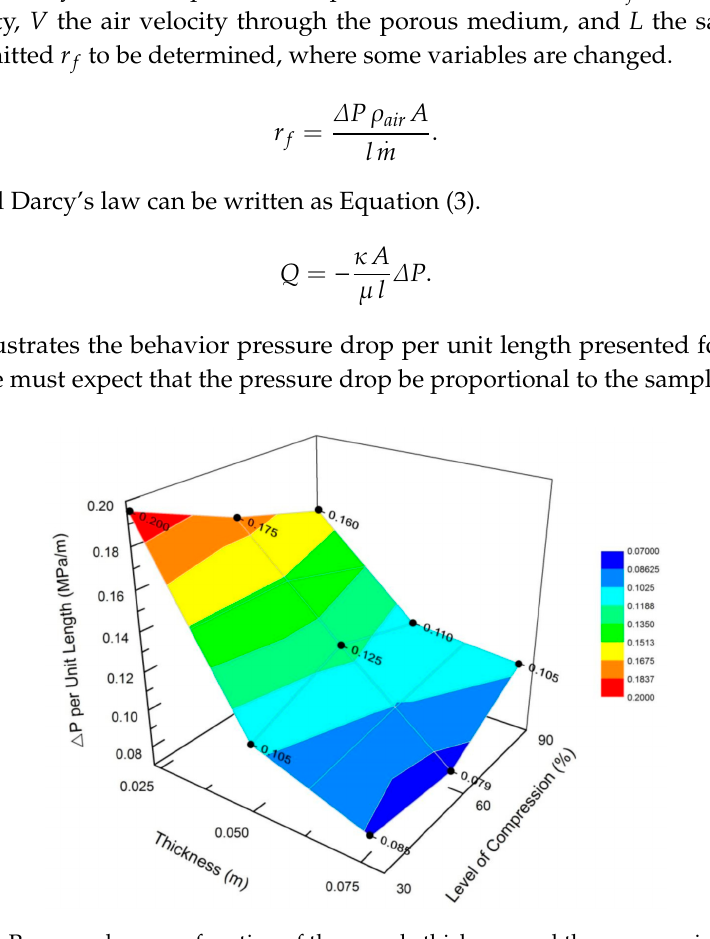
Figure 10. Pressure drop as a function of the sample thickness and the compression percent.